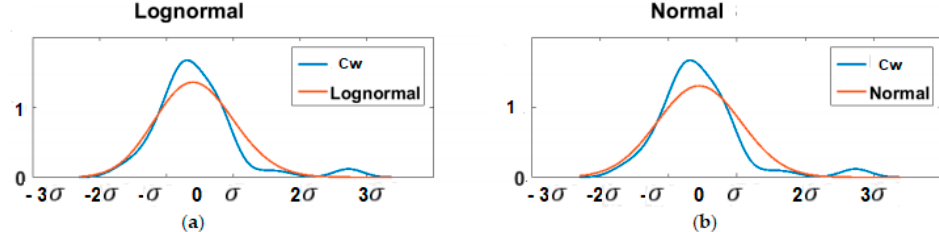
Figure 12. Normal distribution of the probability density of the coefficient c w : ( a ) lognormal, ( b ) normal, σ —standard deviation (3 values are sufficient σ to construct the law of normal distribution, the values of σ selected for each specific case in Matlab).